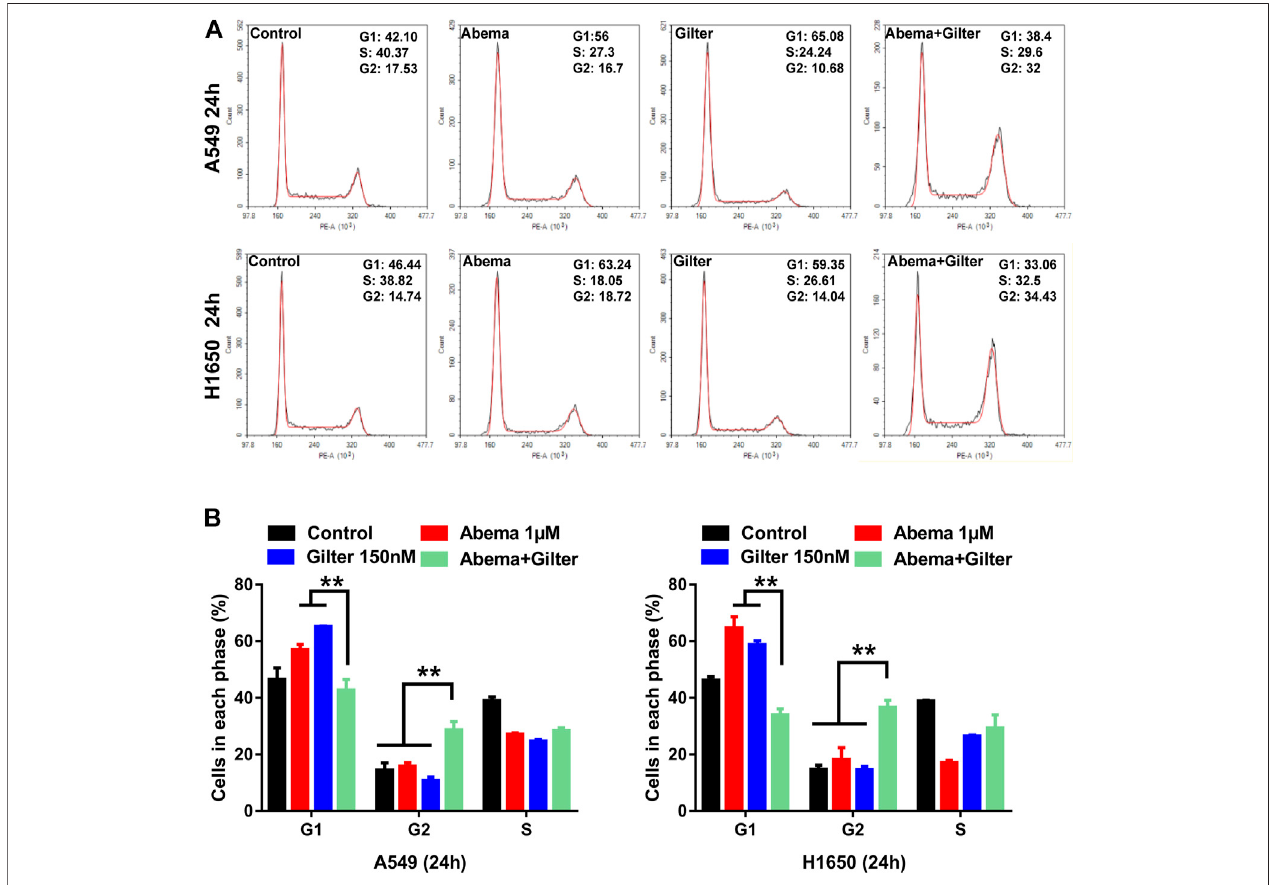
FIGURE5| Abemaciclib incombinationwithgilteritinibinducescell-cyclearrestatG2phaseinlungcancercells (A,B) A549andH1650cellsweretreatedby1 μ M abemaciclib, or 150 nM gilteritinib alone, or their combination for 24 h, and cell cycle was determined by fl ow cytometry ( n = 3). ** p < 0.001.